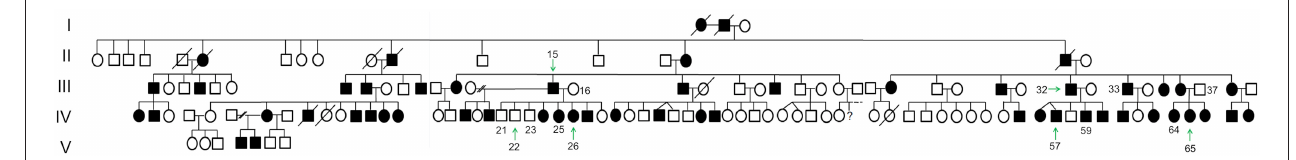
FIGURE 1 | Family pedigree. A large pedigree, spanning 5-generations with 137 individuals, of which 55 are affected, is showing a dominant inheritance pattern. Arrows point to individuals whose exomes were sequenced (affected: III.15, III.32, IV.26, IV.57, IV.65; non-affected: IV.22). Sanger sequencing was performed for the following subjects: affected (III.15, III.32, III.33, IV.25, IV.26, IV.57, IV.59, IV.64, IV.65), non-affected (III.16, III.37, IV.21, IV.22, IV.23).